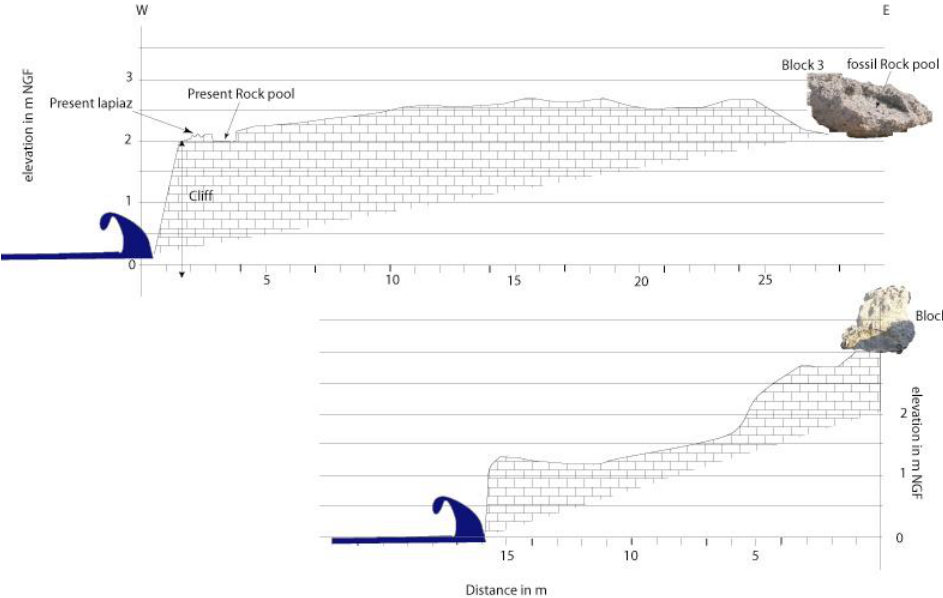
Fig. 5. Location on the aerial profiles of blocks with biological inscrustations, and mega-block 3 with karst morphology marks.